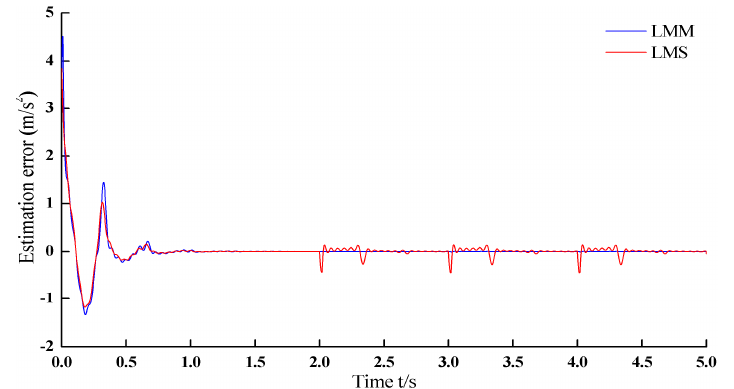
Figure 11. The estimation error when the input signal is contaminated by impulse noise.